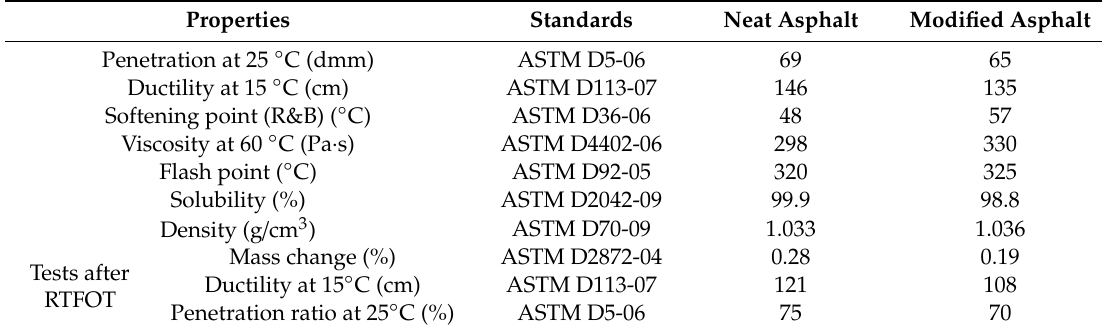
Table 1. Basic properties of neat asphalt and composite anti-aging agent modified